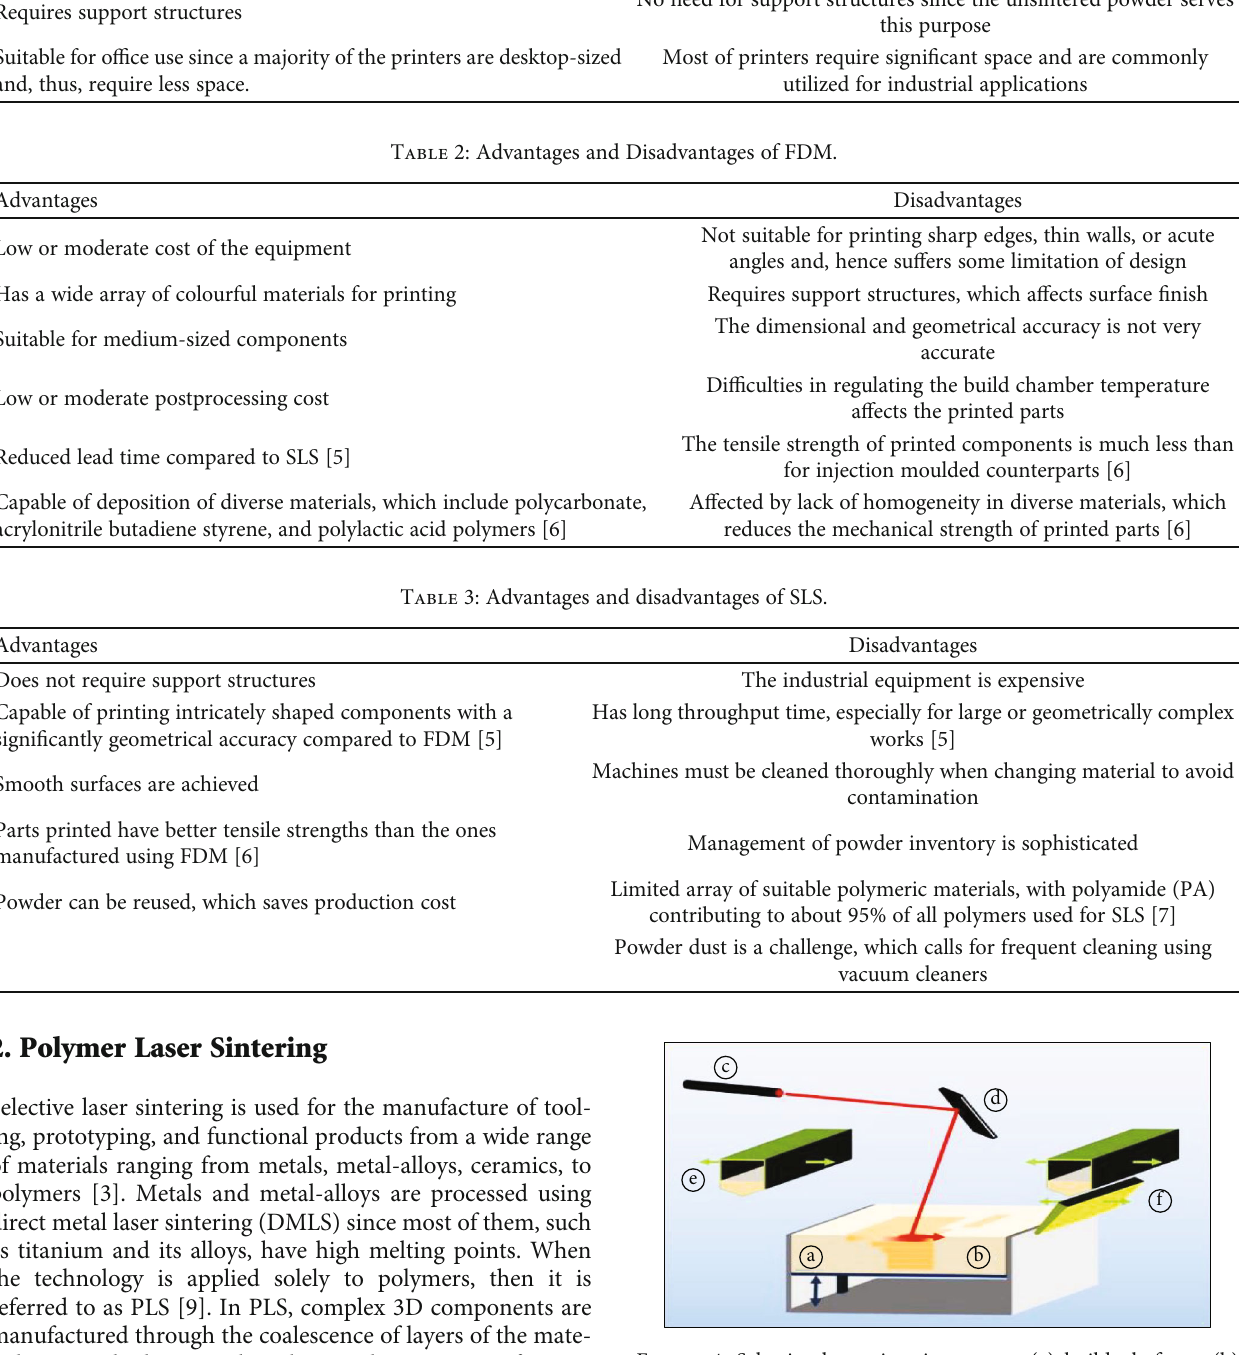
Figure 4: Selective laser sintering set-up, (a) build platform, (b) powder bed, (c) laser beam source, (d) focusing system, (e) powder supply chamber, and (f) recoating blade [2].